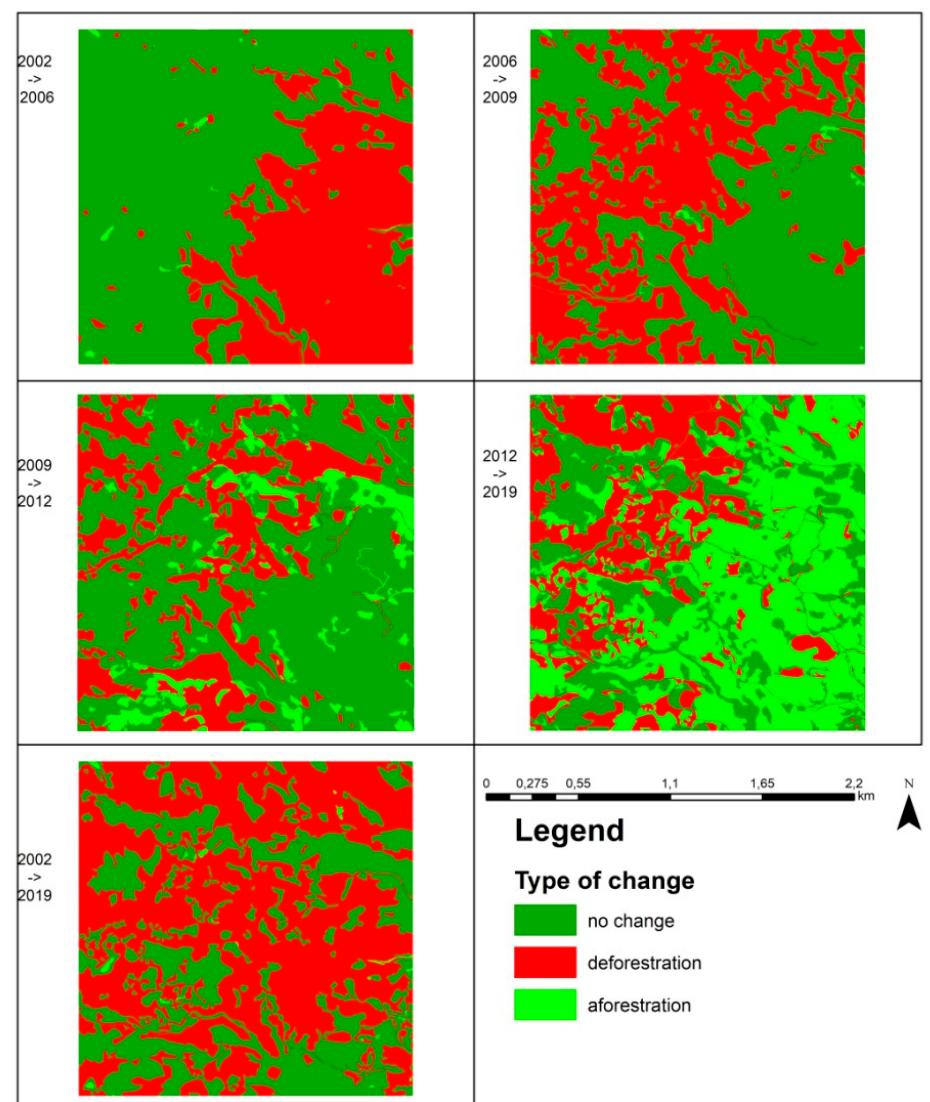
Figure 5. Land cover flows in area NW from Tatransk á Lomnica (TANAP). Elisabeth windstorm (November 2004) and subsequent post-calamity logging were detected as main deforestation drivers. During this period, 12% of the study area was deforested. Between 2006–2009, two other windstorms, Kyrill and Phillip, hit the study area, resulting in minor direct windthrows. As a consequence of these windstorms, massive bark beetle infestation (32441) and controlled logging took place (32411, 26% of the study area was deforested). During following years (2009–2012), ongoing infestation was stopped by the unprecedent logging (resulting in another 40% of the study area being deforested). From 2012, afforestation and connected landscape fragmentation took place, being a consequence of both natural succession and tree planting. Natural forest recovery processes couldn’t be observed, because of anthropogenetic control above deforestation, as well as afforestation. The succession was considerably fast. It took only 6 years for clear-cuts to be covered by young shrubs (32420). On the contrary, there were large areas of clear cuts, which remained unforested (Figure 7, Table